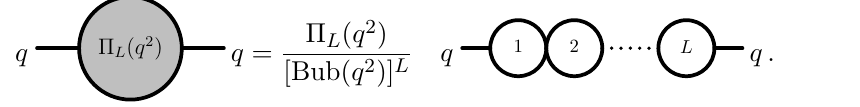
Figure 1 . The hardest diagrams contributing to the n functions for F 2 , ns and F L, ns . In the notation of mincer [41, 42], the two on the left are of the BE topology and the two on the right are O4 cases. All four diagrams have the colour factor C F C A n expects a somewhat simpler form than for the C with two one-loop or one two-loop self-energy insertion(s) contribute. In practice, the non- ζ part of c (4) was the most difficult case, which we solved in Form using an ansatz with a 2 , ns little less than 600 even- N coefficients. All other cases required fewer than 400